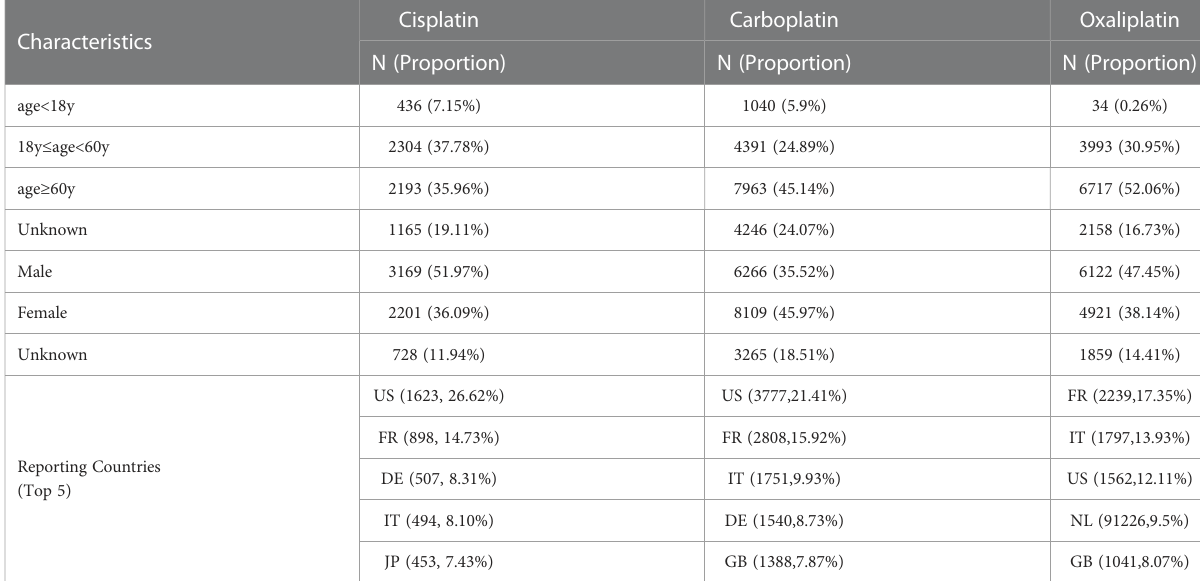
TABLE 1 Characteristics of 36640 Patients.